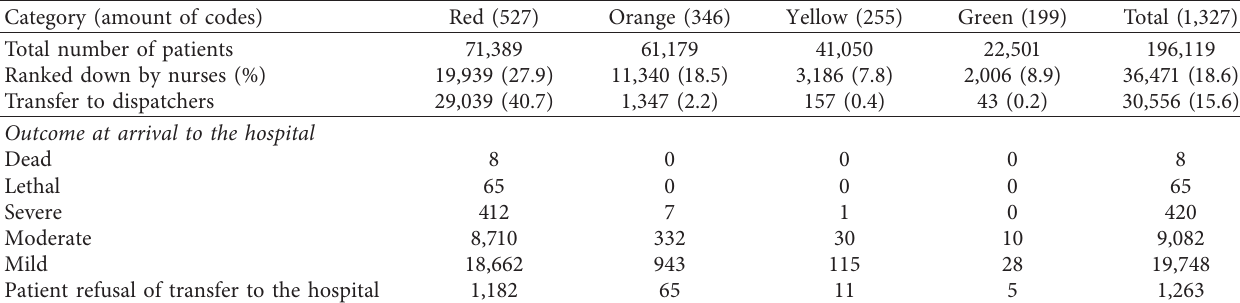
Table 1: Basic data on case numbers linked with the code for each triage category in